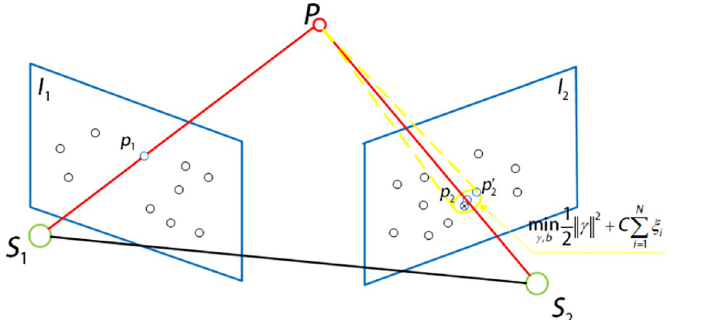
Fig 4. Aeronautical imaging model with soft margin support vector machine.